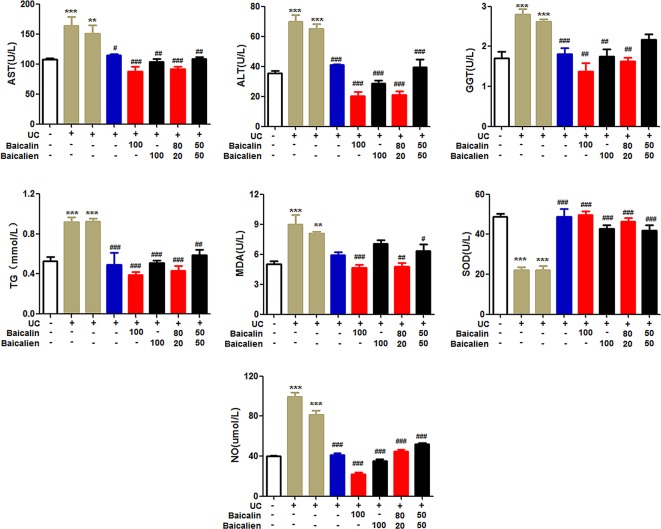
The levels of ALT, AST, GGT, NO, TG, MDA and SOD in rats. Data are presented as the mean ± S.D. (n = 7); **P < 0.01, ***P < 0.001 compared to the NC group; #P < 0.05, ##P < 0.01, ###P < 0.001 compared to the self-healing group. The left second column is UC model group, the left third column is self-healing group, and the left fourth column is SASP group.